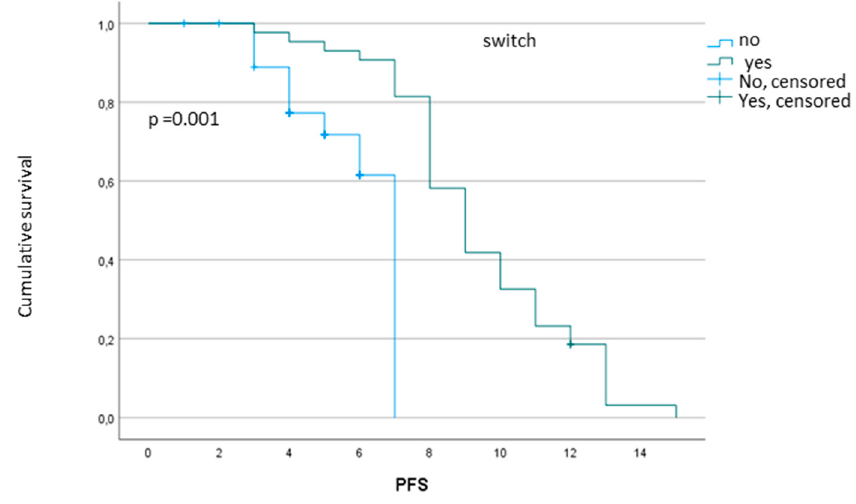
Figure 1. Difference in PFS between bevacizumab-treated patients who switched to RAS wild-type in plasma vs. patients who remained RAS mutant .